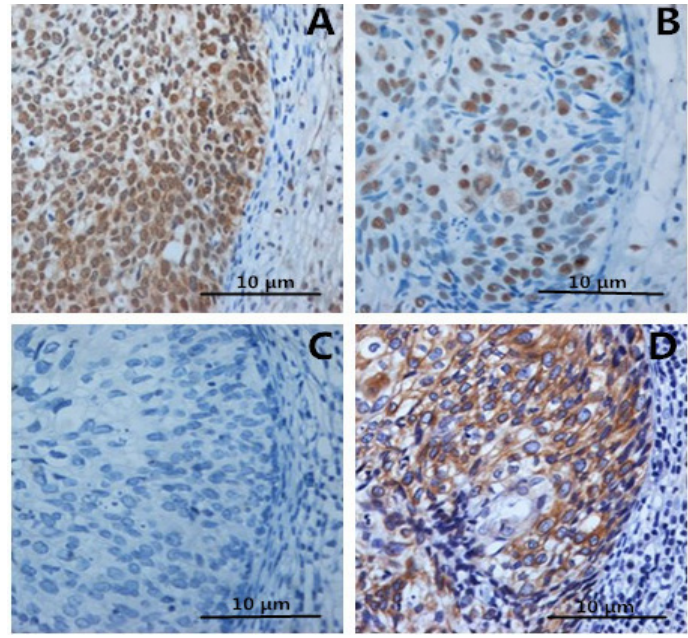
Figure 4. As shown in immunostaining of A (HMGB1), B (Foxp3) and D (IL-10), most of Foxp3+ Tregs are IL-10-positive. Tregs have been known to be IL-2-negative, as shown in C